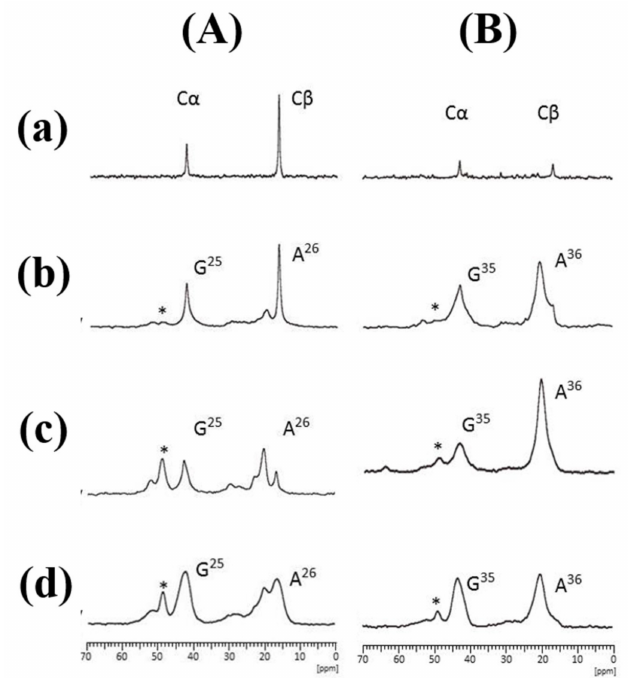
Figure 11. 13 C solid-state NMR spectra ( a – d ) of 47-mer peptides with 13 C-labeled motifs; ( A ) [2- 13 C]Gly 25 [3- 13 C]Ala 26 [1- 13 C]Gly 27 and ( B ) [2- 13 C]Gly 35 [3- 13 C]Ala 36 [1- 13 C]Gly 37 . ( a ) 13 C r-INEPT, ( b ) 13 C DD / MAS and ( c ) 13 C CP / MAS spectra in the hydrated state, and ( d ) 13 C CP / MAS spectrum in the dry state [60]. The peaks marked by asterisk * were assigned to Ala C α peaks of non-labeled (Ala) 6 in the